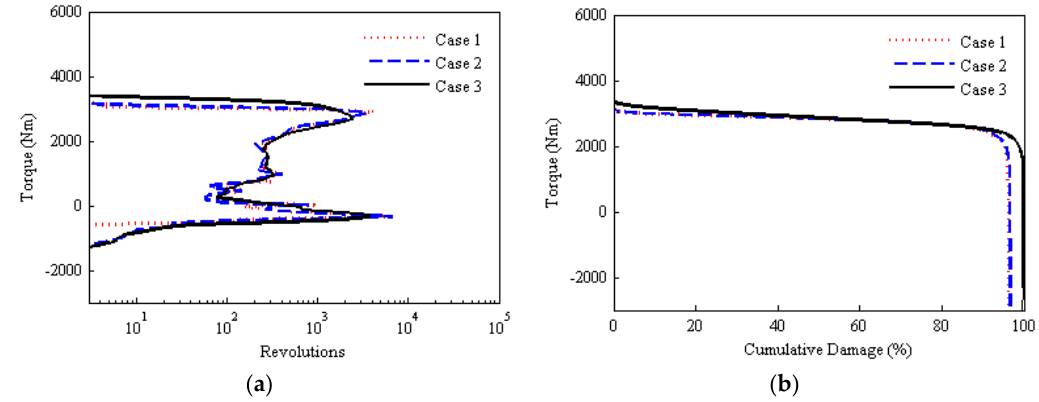
Figure 13. Rotating moment histogram (RMH) analysis of the engine output shaft toque: ( a ) torque vs. revolutions ( b ) torque vs. cumulative damage (%).